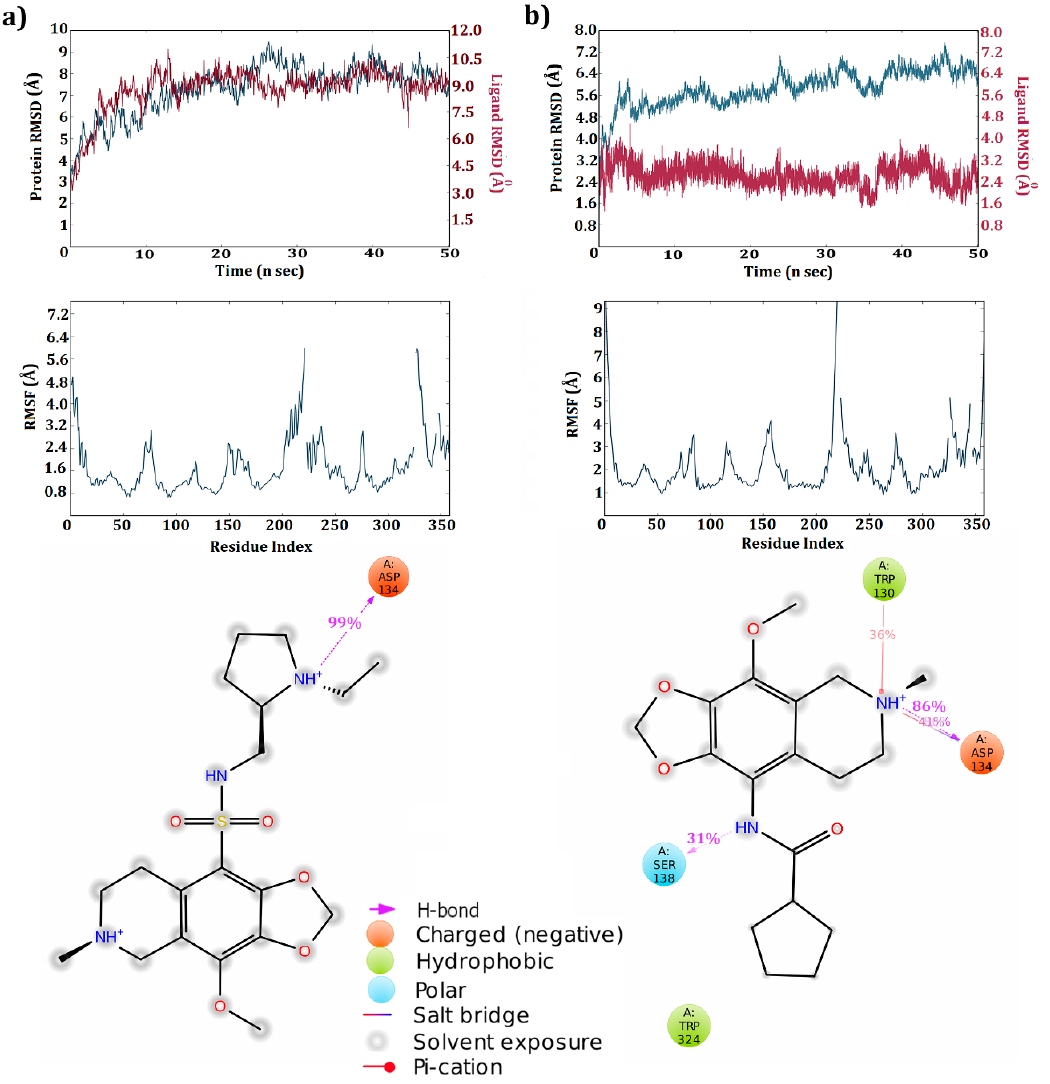
Figure 4. Deviations, fluctuations, and interaction percentages between the 5HT 2C receptor and molecules at the end of 50 ns simulation run: ( a ) 5HT 2C —ZINC40312983; ( b ) 5HT 2C —ZINC32124535.